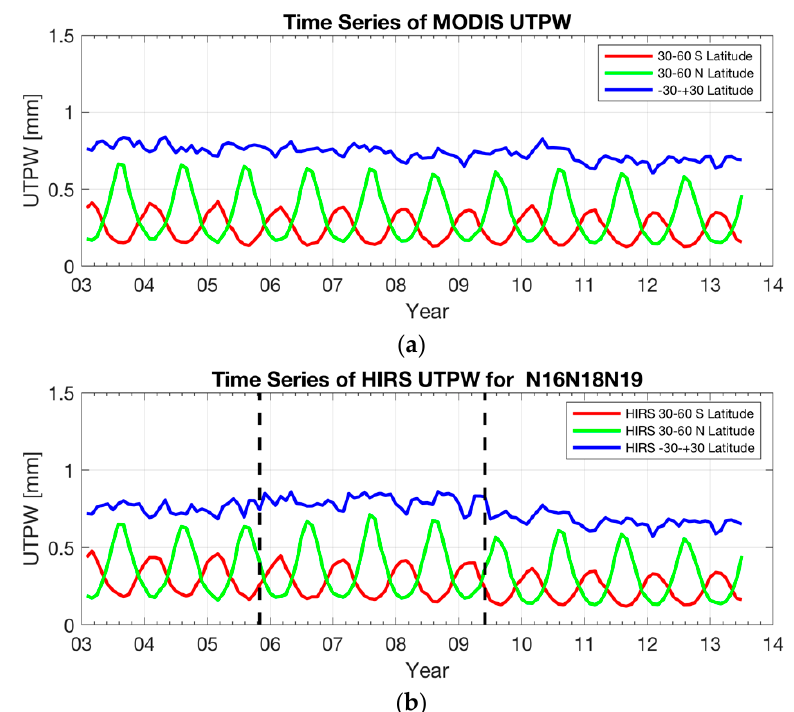
Figure 4. Time Series of UTPW detection for Aqua MODIS ( a ) and NOAA-16, -18, and -19 HIRS ( b ) from 2003 to 2014 for five latitude bands (mid latitude north 30° to 60° N, tropics 30° N to 30° S, and mid latitude south 30° to 60° S). Zonal mean values of MODIS and HIRS, and their differences (MODIS-HIRS) for 1 degree latitude bands for TPW and UTPW, are shown in Figures 5 and 6. MODIS and HIRS TPW are within 2 mm for all latitudes; MODIS is wetter than HIRS from 20° S to 20°